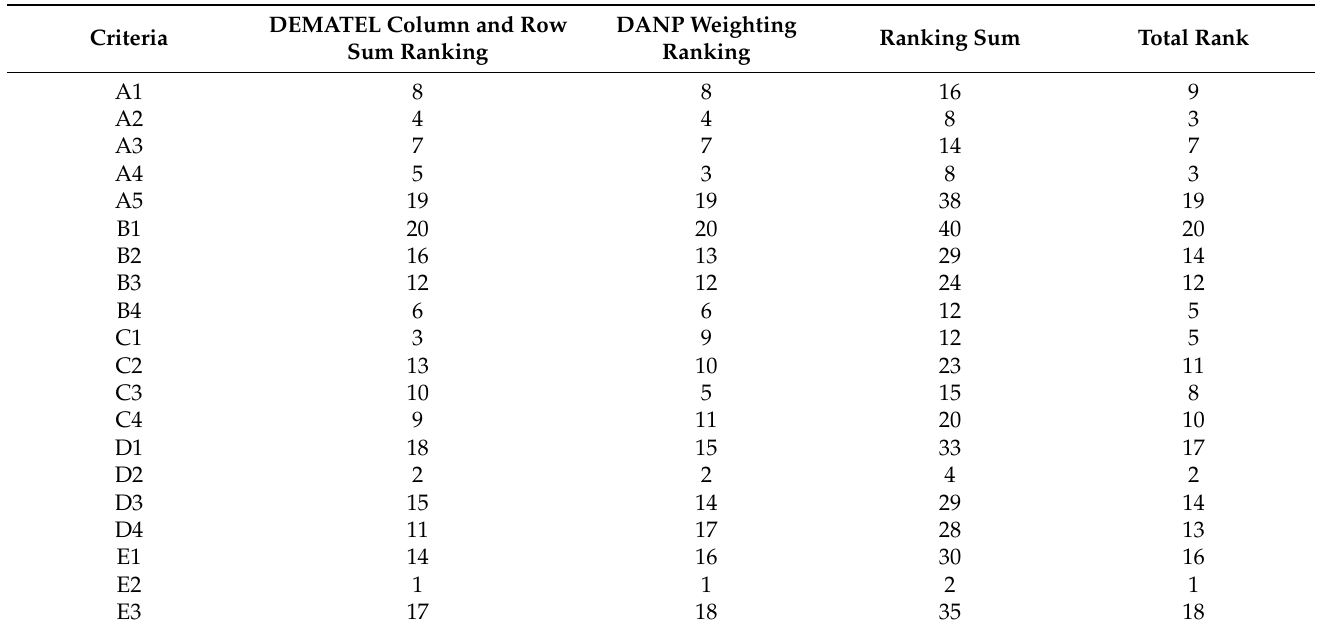
Table 4. Summary of the weighting of